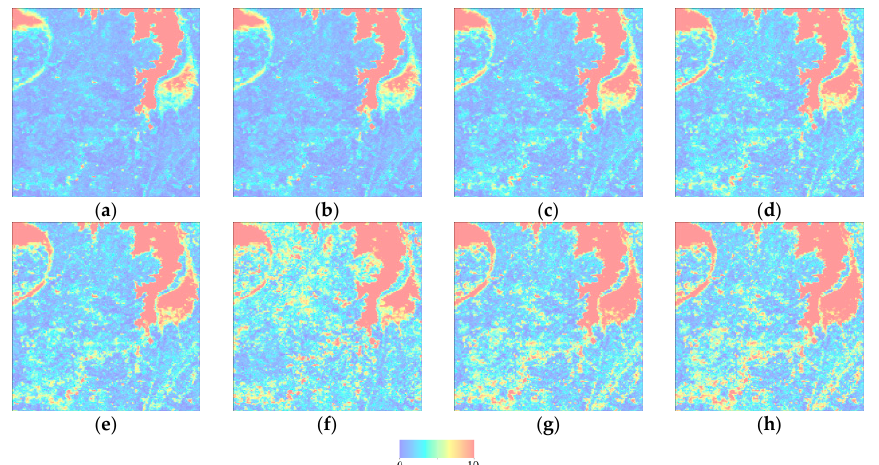
Figure 6. OLWDTW distance of single-cropped rice paddy cover in test site 1 with different enhance factor σ values: ( a ) σ = 1.5; ( b ) σ = 2; ( c ) σ = 2.5; ( d ) σ = 3; ( e ) σ = 3.5; ( f ) σ = 4; ( g ) σ = 4.5; ( h ) σ = 5.